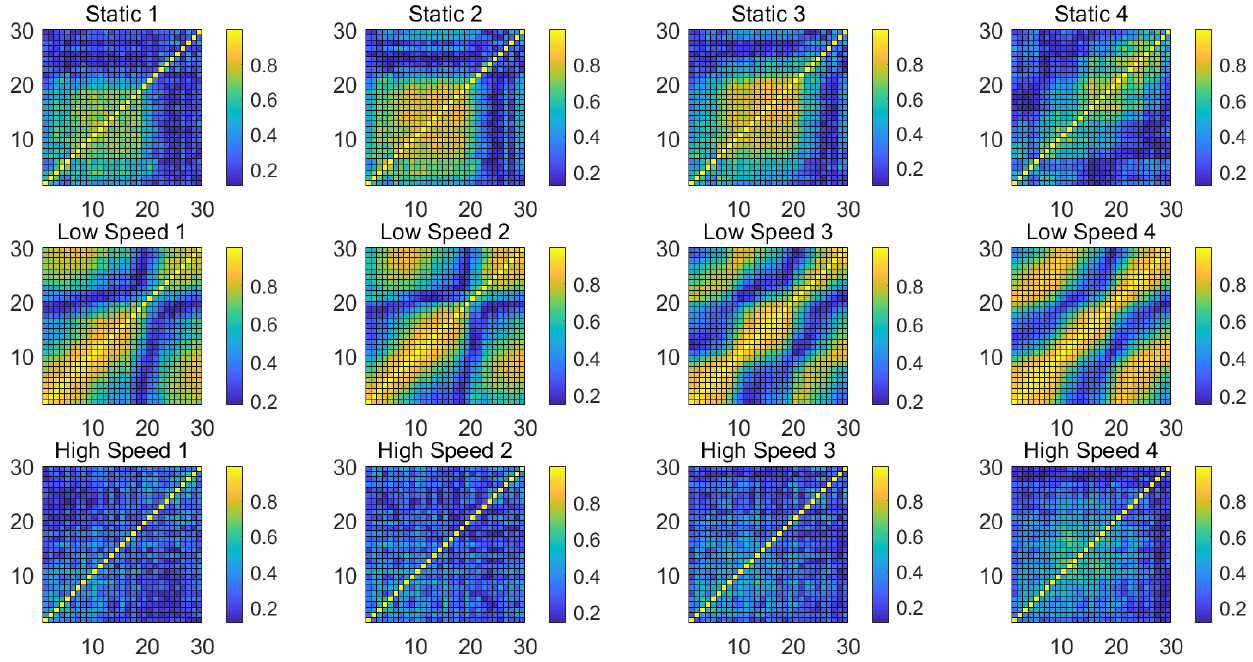
Figure 8. Dynamic distribution of subcarrier correlation matrix of three scenarios including static, dynamic with slow speed and dynamic with high speed using a random sliding window.